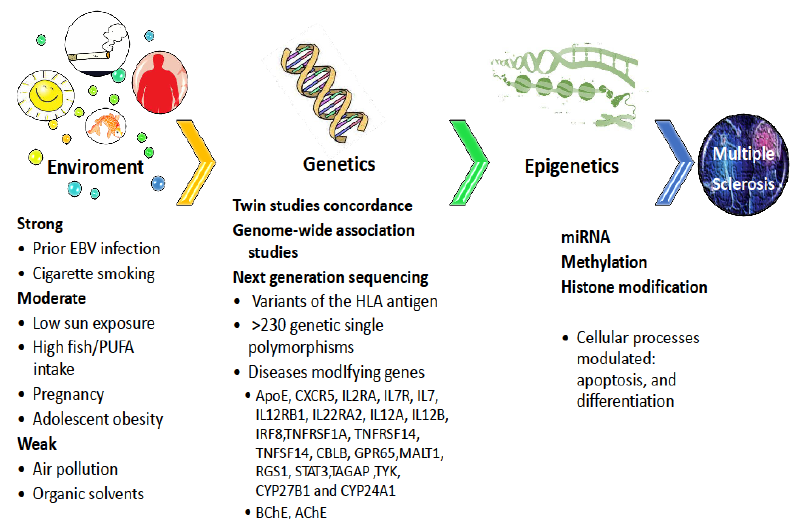
Figure 2. Risk factors for multiple sclerosis (MS). A hereditary basis of MS is suggested by epidemiological studies and recurrence risk of MS in twins, siblings, conjugal MS individuals. MS is believed to result from multiple independent or interacting polymorphism genes as well as their interaction with behavioral and environmental factors with strong, moderate, or weak effects. Epigenetic mechanisms that have been detected for MS pathogenesis are DNA methylation, histone modification and some microRNAs